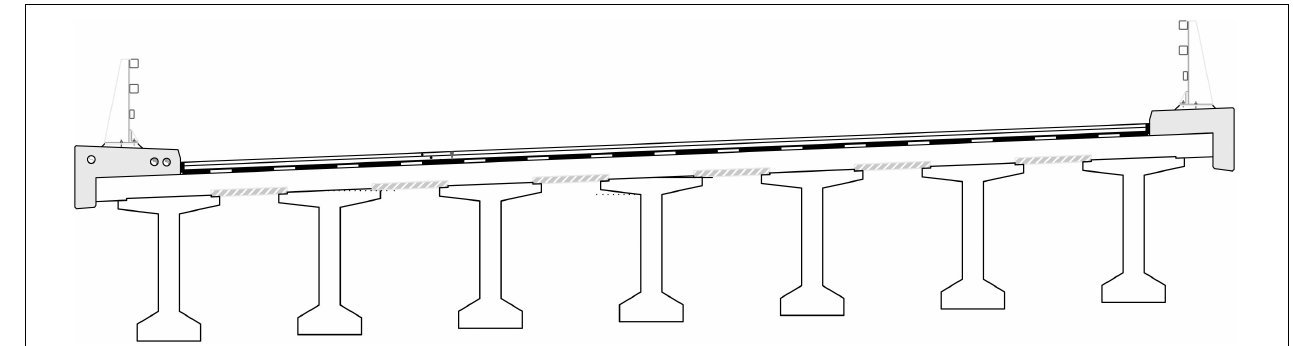
FIGURE 4 | Typical precast beam bridge cross section